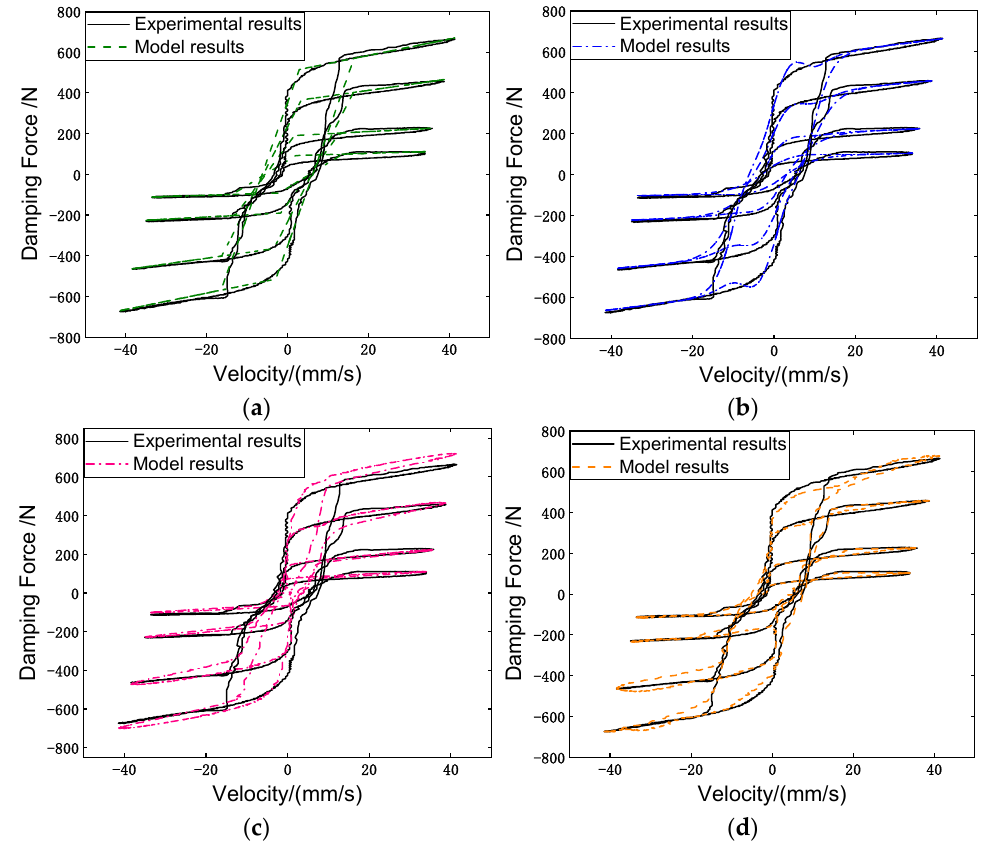
Figure 5. Comparison of the model results with the experimental results. ( a ) Hysteretic bi-viscous model; ( b ) Viscoelastic-plastic model; ( c ) Bouc–Wen model; and ( d ) Modified Bouc–Wen model.